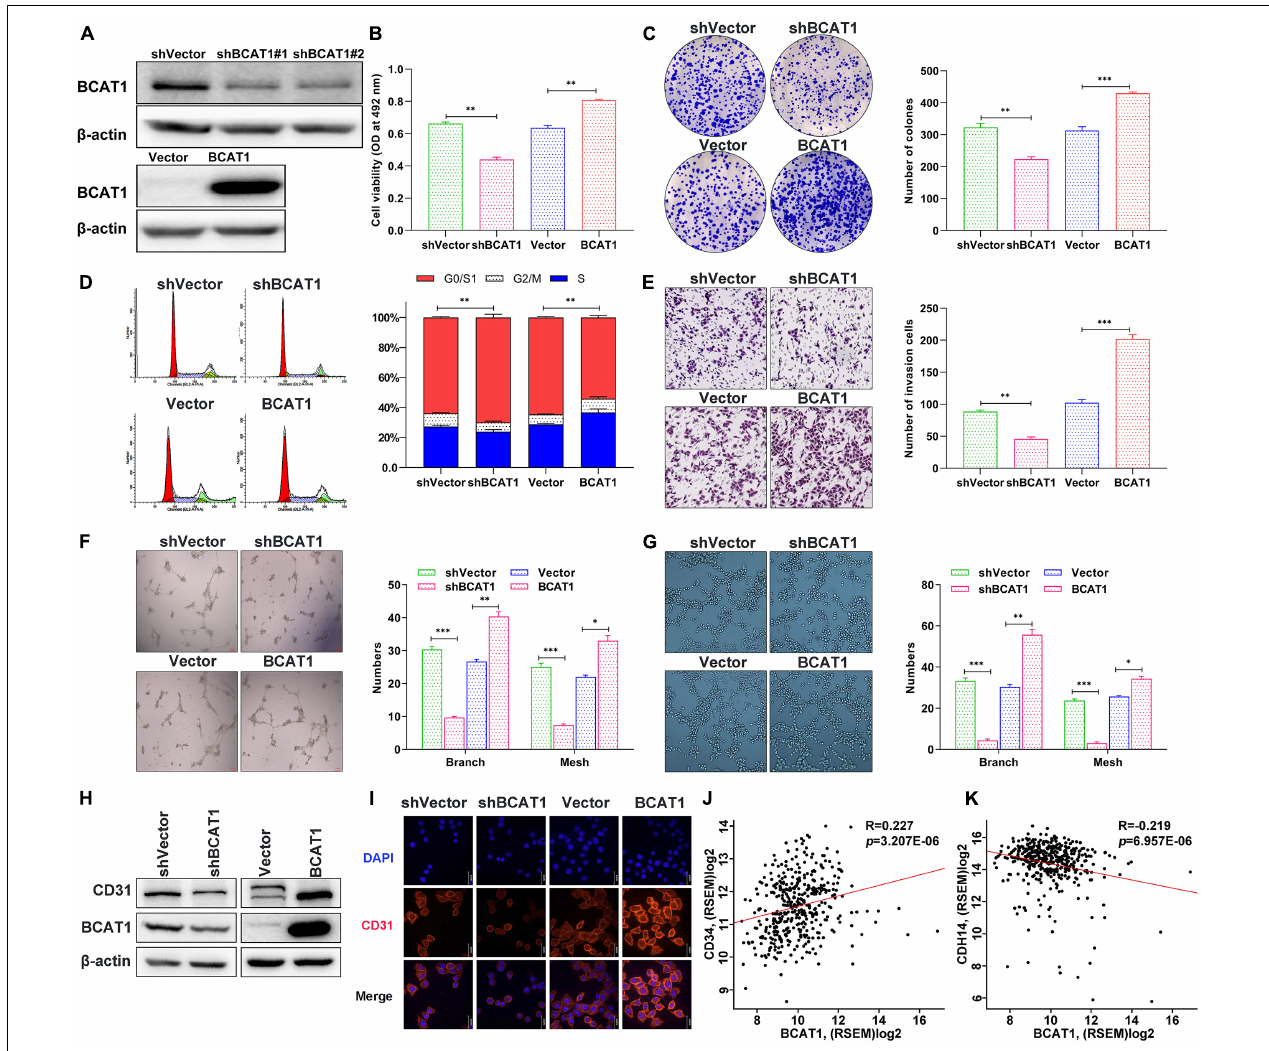
FIGURE 3 | BCAT1 promotes proliferation, invasion, and angiogenesis of GC cells in vitro . BGC823 cells were transfected with lentivirus vector to induce BCAT1 silencing (shBCAT1) or overexpression (BCAT1). (A) Western blot confirming the downregulation (upper panel) or upregulation (lower panel) of BCAT1 in BGC823 cells. (B) MTT assay showing the viability of transfected cells. (C) Representative images of colony formation assay in transfected cells (right panel) and quantitative results (left panel). (D) Representative images of flow cytometric cell cycle analysis in transfected cells (right panel) and quantitative results (left panel). (E) Representative images of Transwell invasion assay in transfected cells (right panel) and quantitative results (left panel). (F,G) HUVEC tube formation assays were performed to evaluate angiogenesis ability. Representative images and quantitative results of HUVECs (F) and BGC-823 cells (G) are shown. (H) Western blot and (I) immunofluorescence assay for CD31 protein expression in transfected cells. (J,K) Correlation analysis of BCAY1 expression with CD34 angiogenic marker, (J) or CDH14 invasion marker, (K) in TCGA GC dataset. * p < 0.05, ** p < 0.01, *** p < 0.001. Data are expressed as mean ± SEM of three independent